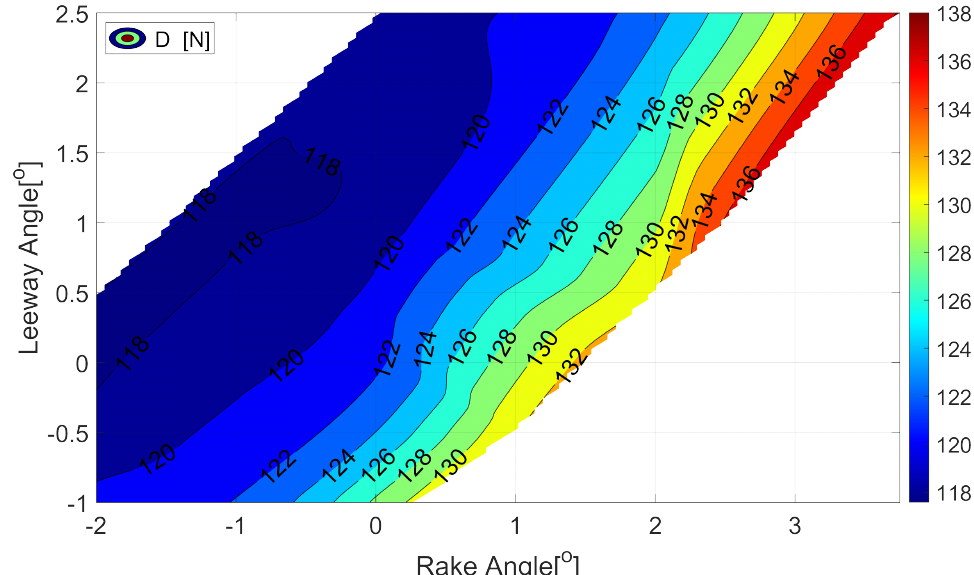
Figure 32. Computed drag force at 9 m/s, dimensions are in [N].